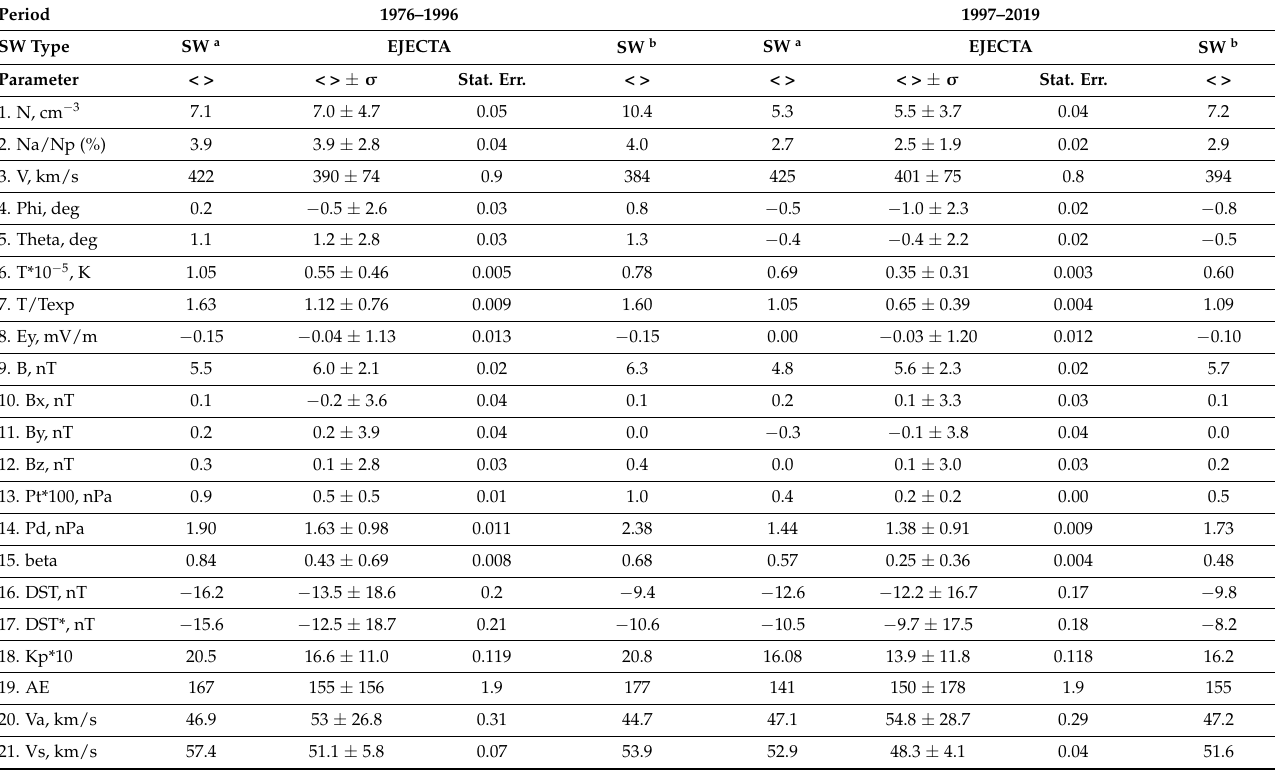
Table 3. Average parameters for sequence SW/EJECTA/SW (Figure 3).